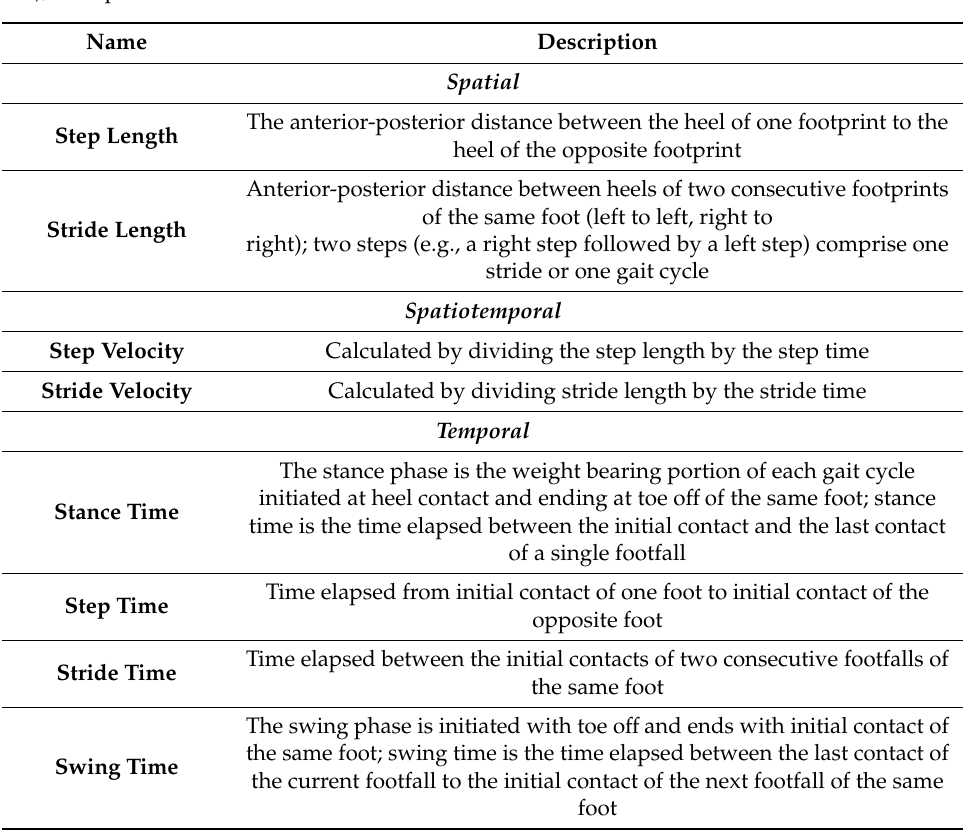
Figure 5. The heel-contact/initial contact (IC) and toe-off/final contact (FC) points identified from local minima and local maxima of the Gaussian continuous wavelet transform, of the processed vertical accelerometer signal. Table 1. Definitions of gait characteristics, reprinted from Hollman, J.H.; McDade, E.M.; Petersen, R.C. Normative Spatiotemporal Gait Parameters in Older Adults. Gait Posture 2001 , 34 , 111–118, Copyright (2011), with permission from